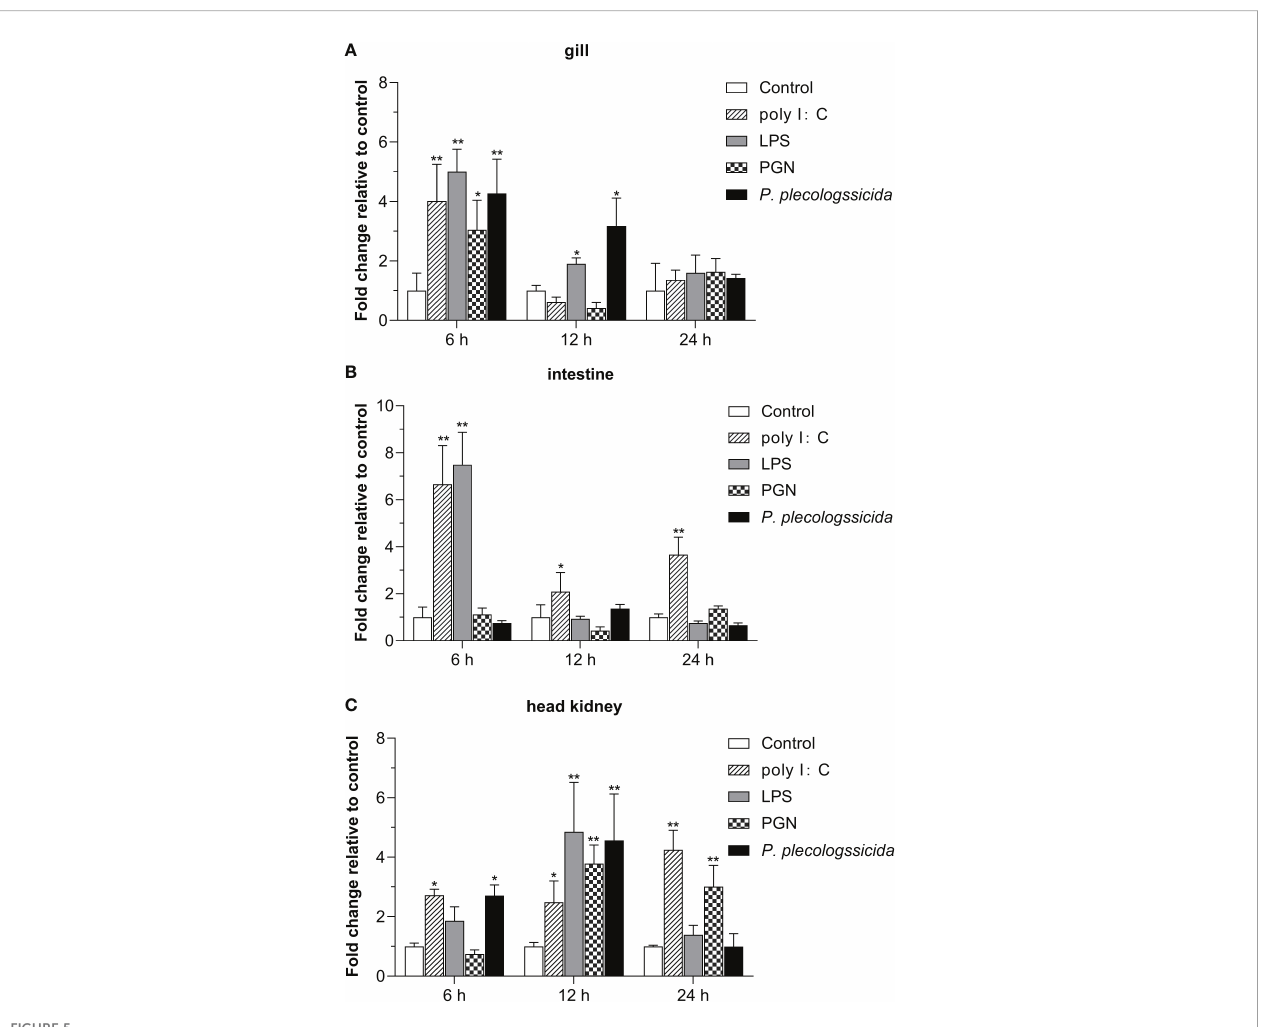
FIGURE 5 Expression patterns of Lc-SARM in response to the stimulations of poly I:C, LPS, PGN, and P. plecoglossicida . The healthy large yellow croakers ( fi ve groups) were injected intraperitoneally with 100 m L of poly I:C (1 mg/mL), LPS (0.5 mg/mL), PGN (1 mg/mL), P. plecoglossicida suspension in PBS (5 × 10 5 CFU/mL), and sterile PBS (control), respectively. Six large yellow croakers were randomly selected from each group at 6, 12, and 24 hpi and the mRNA expression levels of Lc-SARM in the gill (A) , intestine (B) , and head kidney (C) were examined by qRT-PCR. The results were calculated by normalization to the expression of L. crocea b -actin and then recorded as fold change relative to the PBS injection group (control) at the same time point. All of the data are shown as the mean of three individual experiments, with bars representing the SE. Statistically signi fi cant differences are indicated by the asterisks (* P < 0.05, ** P <